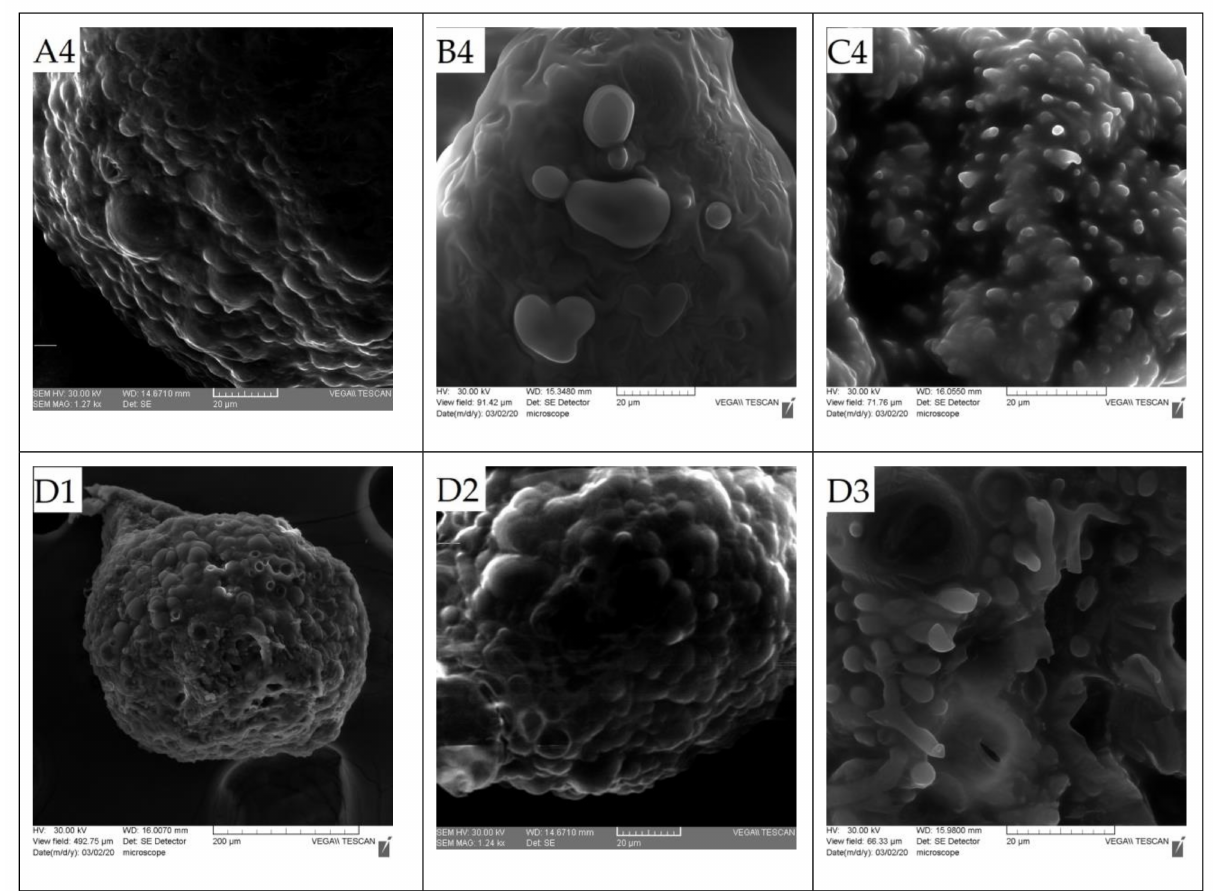
Figure 2. Capsule morphology—general image and wall image—prepared with different probiotics ( A )–oligofructose, ( B )– starch, ( C )–inulin, ( D )–glucose) captured with scanning electron microscope. ( A1 , A2 , B1 , B2 , C1 , C2 ) and ( D1 )—microcapsule image, ( A3 , A4 , B3 , B4 , C3 , C4 ) and ( D2 , D3 )—microcapsule